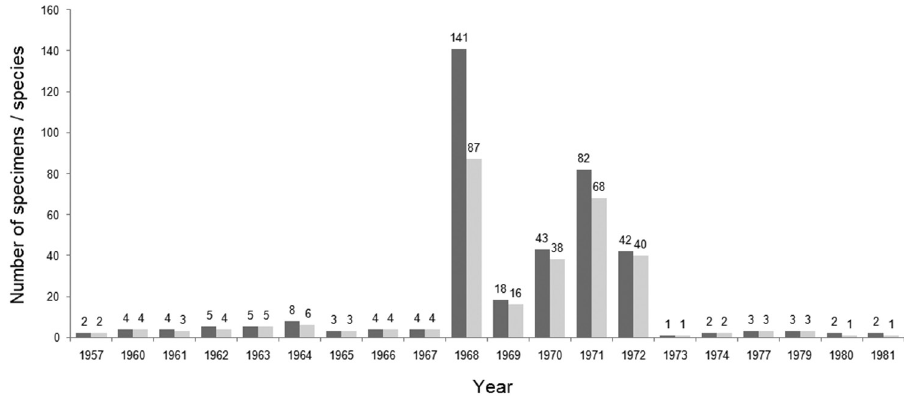
Figure 3. Temporal distribution of numbers of bird specimens (dark grey) and species (light grey) added to the Šariš Museum in Bardejov exotic bird collection during